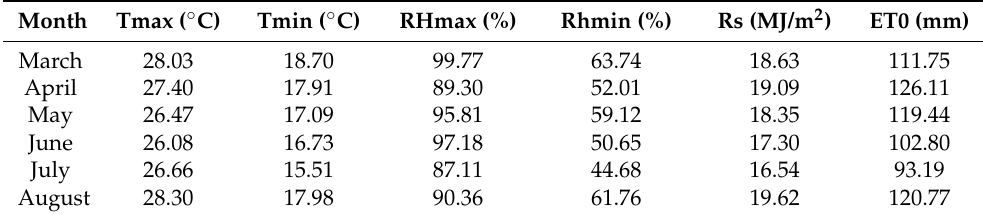
Table 3. Monthly weather data during the field study at the Ukulinga Research Station of the University of KwaZulu-Natal during the 2019 growing